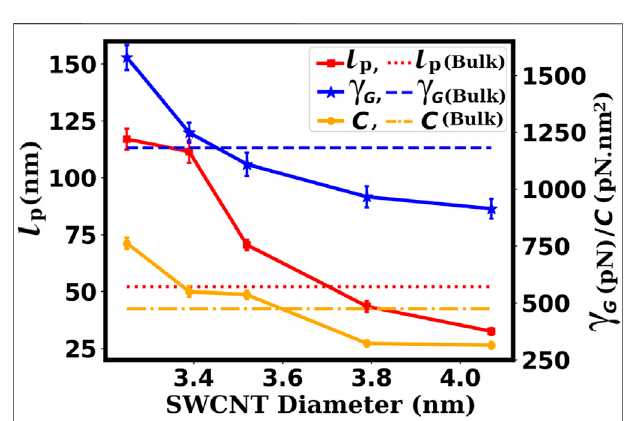
FIGURE12| Variationofthepersistencelength( l p ),stretchmodulus( γ G ), and torsional stiffness ( C ) of the con fi ned dsDNA with respect to the diameter oftheSWCNT.ThedsDNAshowshighrigidityformoderatecon fi nement,and for weak con fi nement, the dsDNA shows high fl exibility to bend, stretch, and twist. The dashed and dotted lines represent the values for the bulk